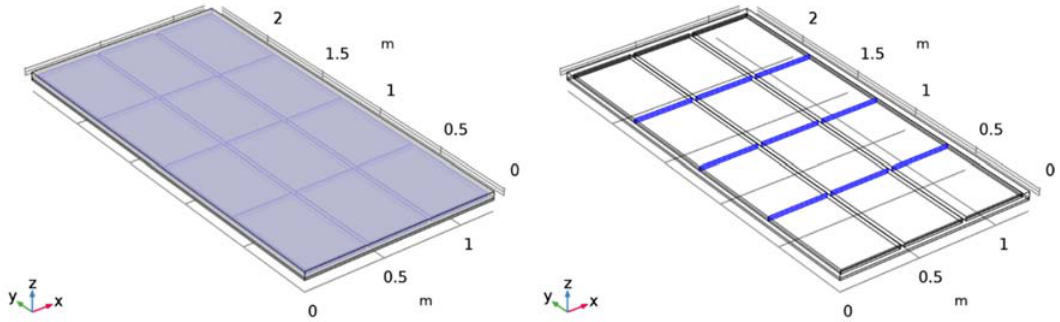
Figure 8. Model of large ‐ scale composite ‘A’, with the embedded VIPs ( left ) and VIP ‐ VIP interfaces ( right ) highlighted in blue.